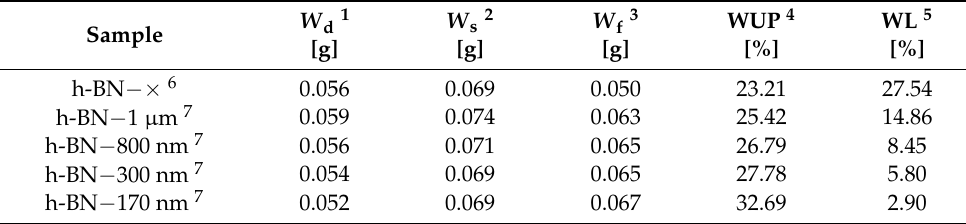
Table 1. Water uptake (WUP) and weight loss (WL) of IEAP actuators without and with h-BN insulating layers.